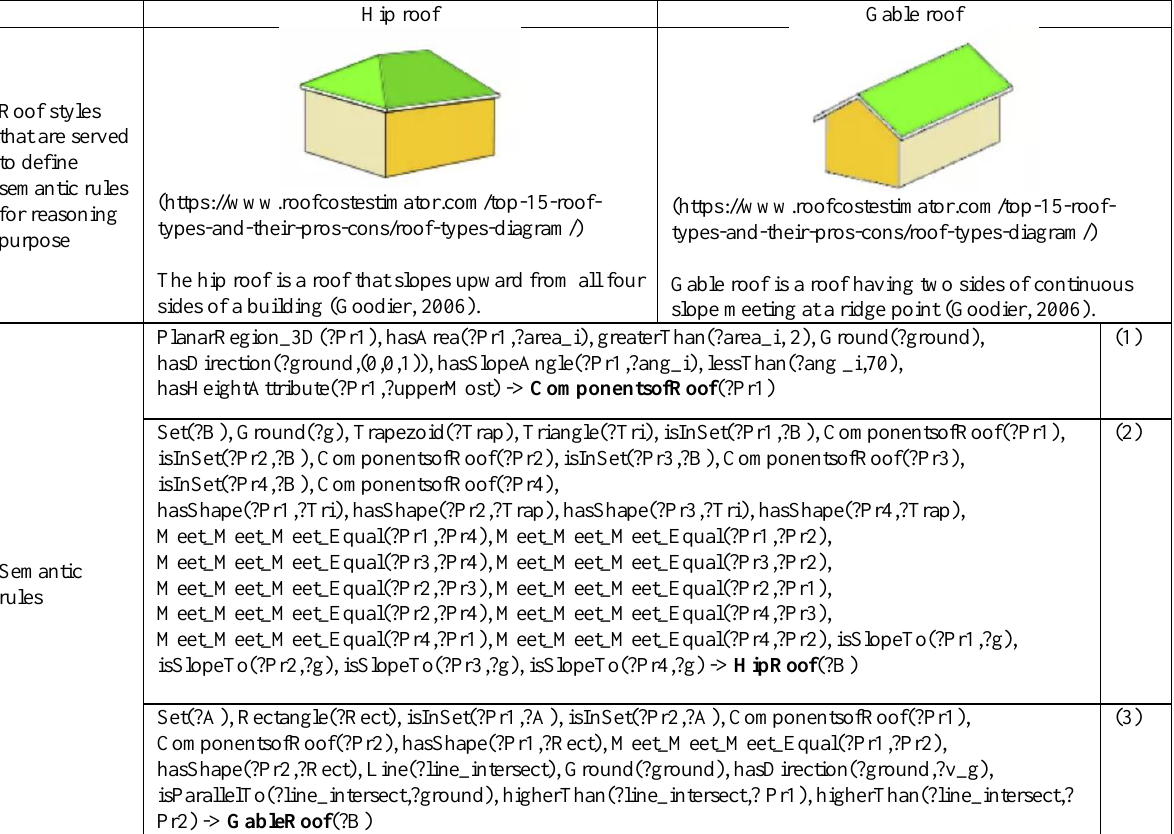
Table 2 Building roof styles and the defined rules for recognizing building roof styles from point clouds